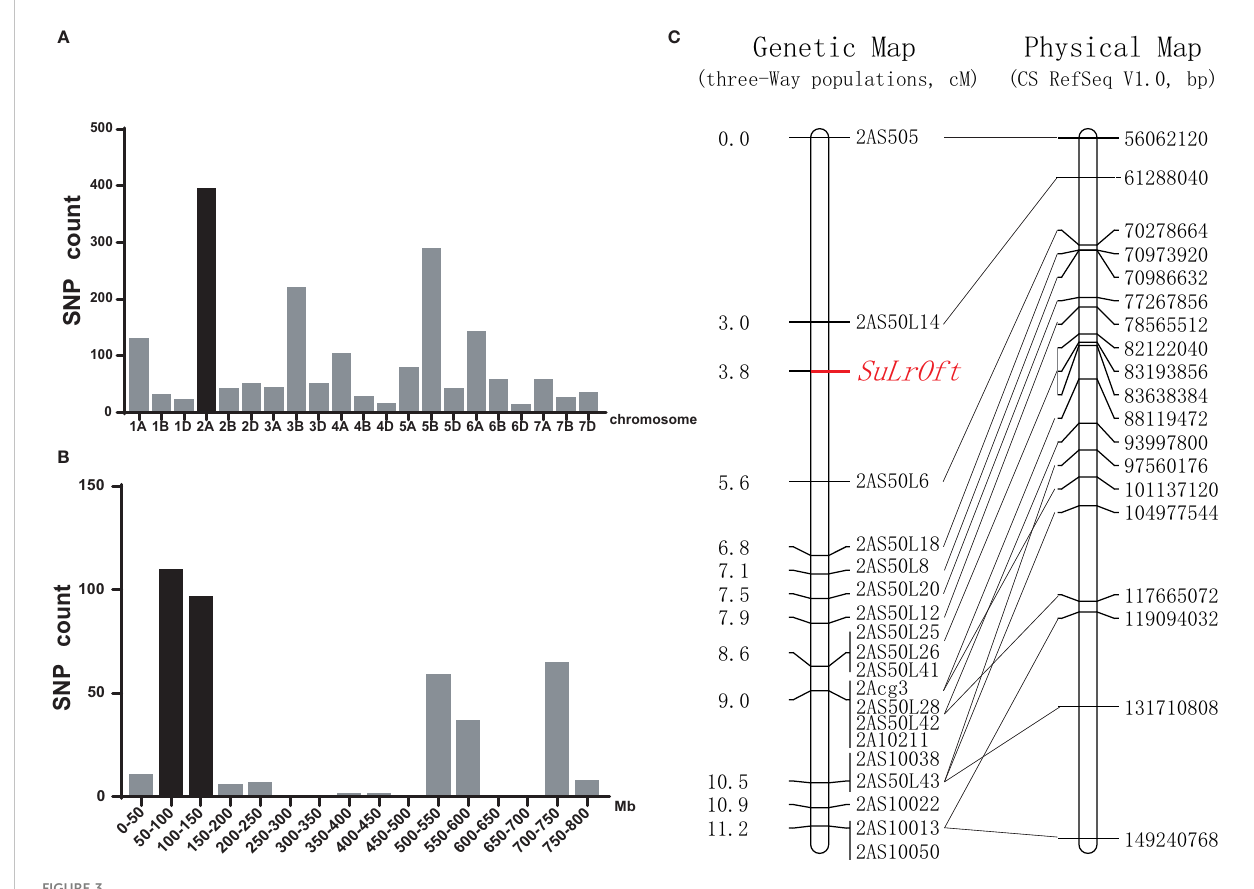
FIGURE 3 Chromosomal location of the SuLrOft locus. (A) Distribution of the candidate heterozygous/homozygous SNPs between the resistant and susceptible DNA pools from the Shi4185/ND4503//Ofanto three-way cross on each chromosome; (B) distribution of candidate SNPs on chromosome 2A according to the CS reference genome (IWGSC RefSeq v1.1); (C) genetic linkage map for chromosome arm 2AS and the collinearity of the developed markers corresponding to their physical positions in CS IWGSC RefSeq v1.0